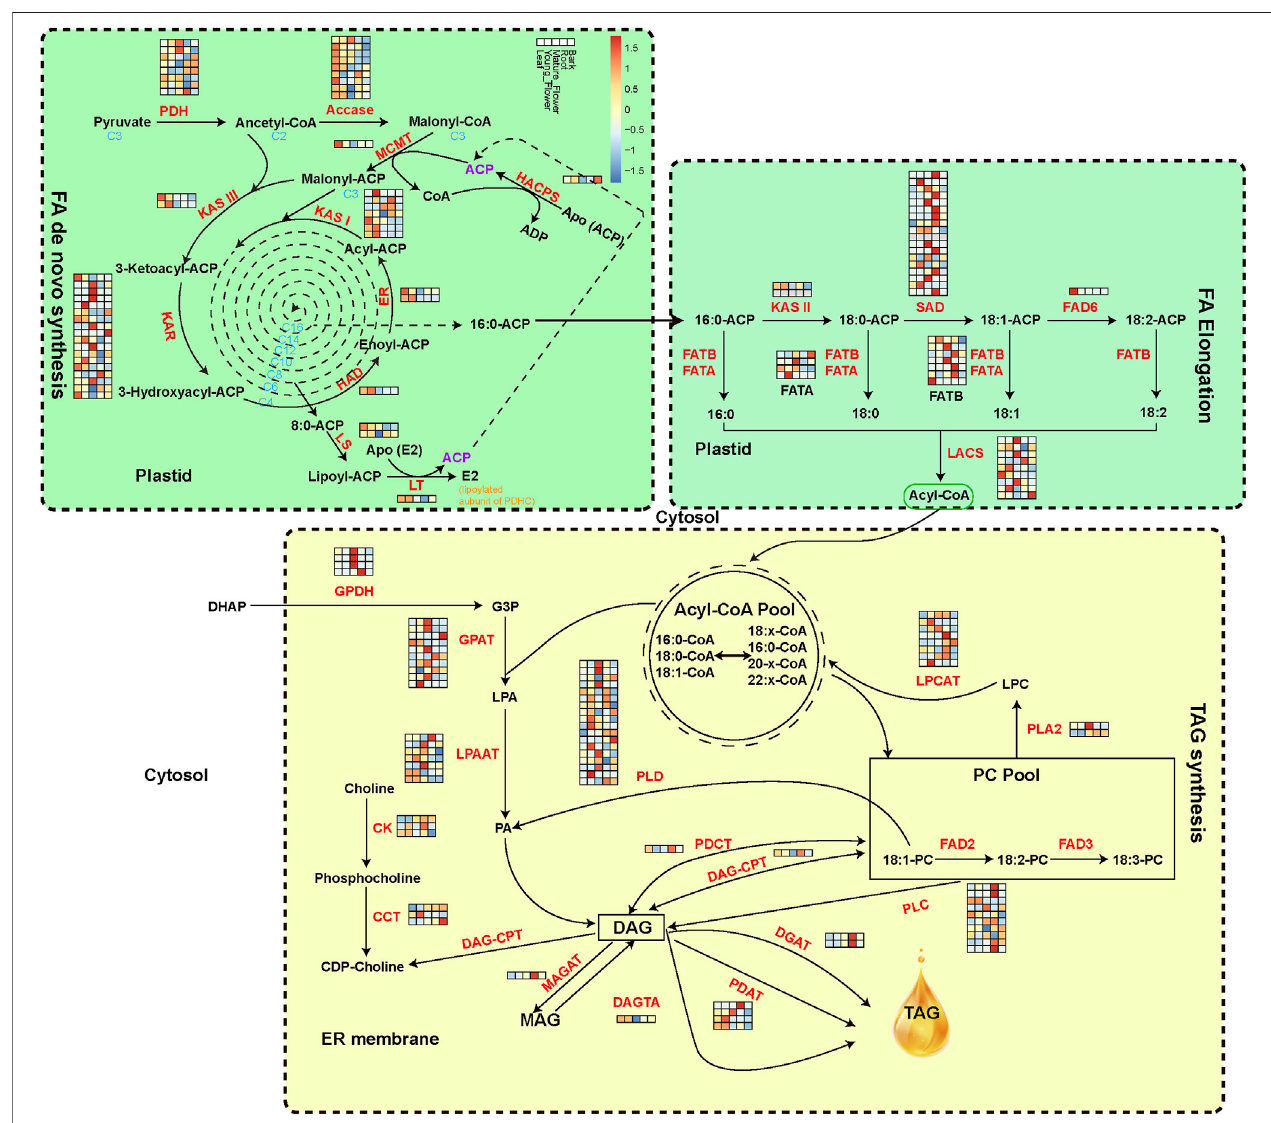
FIGURE 3 | Expression level of oil biosynthesis-related genes. Acetyl-CoA is converted into C16 and C18 fatty acids in the plastid. TAG is synthesized in the endoplasmic reticulum and packed in the oil bodies. The isozymes and metabolites involved in oil biosynthesis were colored in red and black, respectively. The expression levels of oil-biosynthesis genes from leaf, young fl ower, mature fl ower, root and bark, are presented with the heat map.